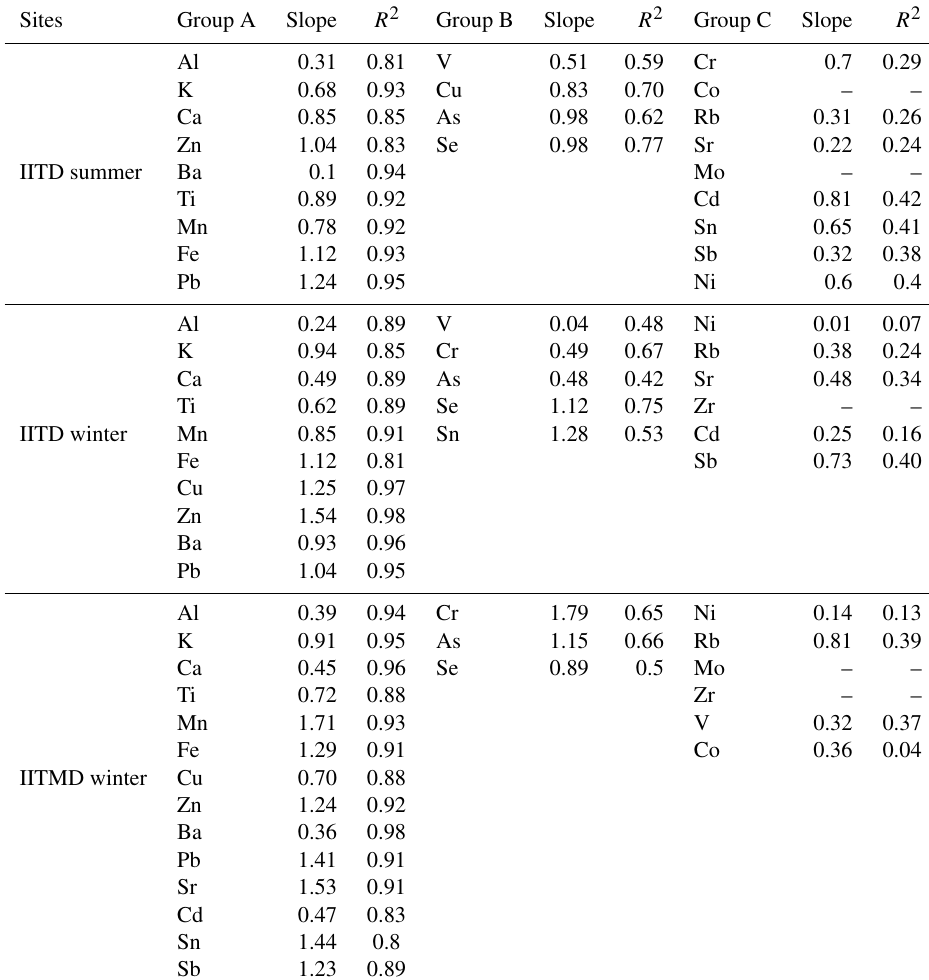
Table 3. Regression coefficients and slopes for the comparison of Xact 625i and ICP-MS measurements.